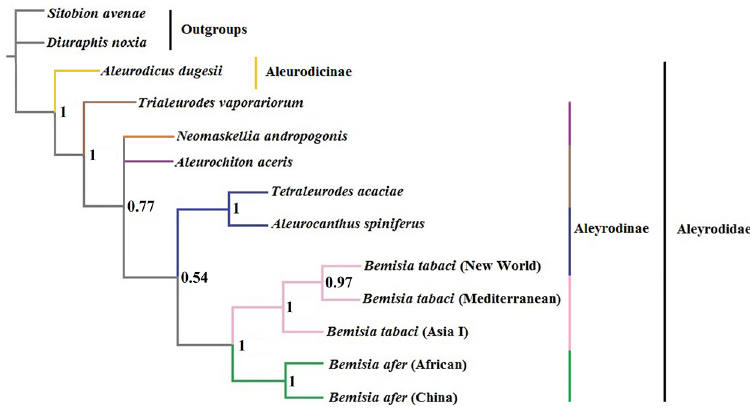
Fig 11. Inferred phylogenetic relationships among Aleyrodidae based on three selected PCGs. Numbers at the nodes are Bayesian posterior probabilities. The tree was rooted with two outgroups ( S . avenae and D . noxia